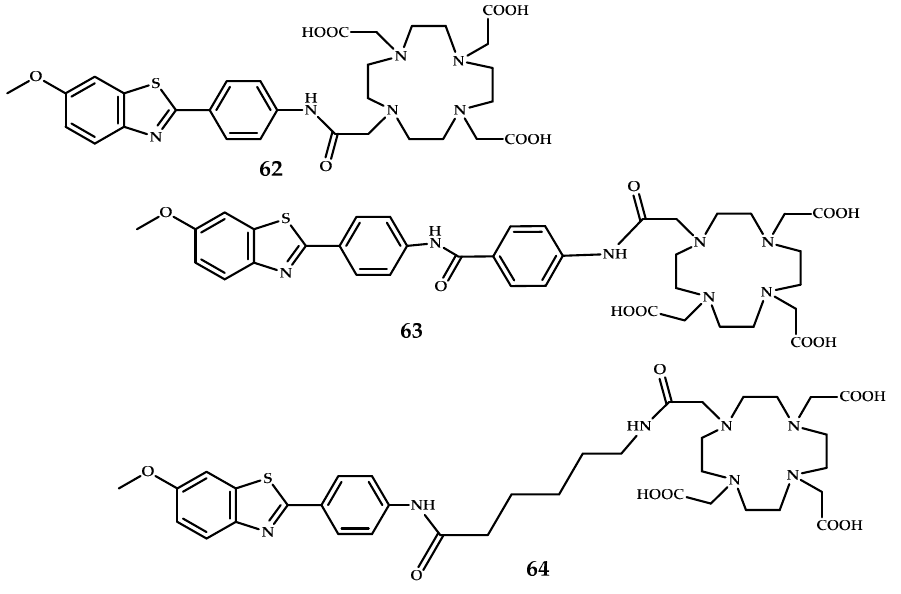
Figure 15. DOTA–Pib–based ligands L62–L64 . Figure 15. DOTA-Pib-based ligands L62 – L64 .